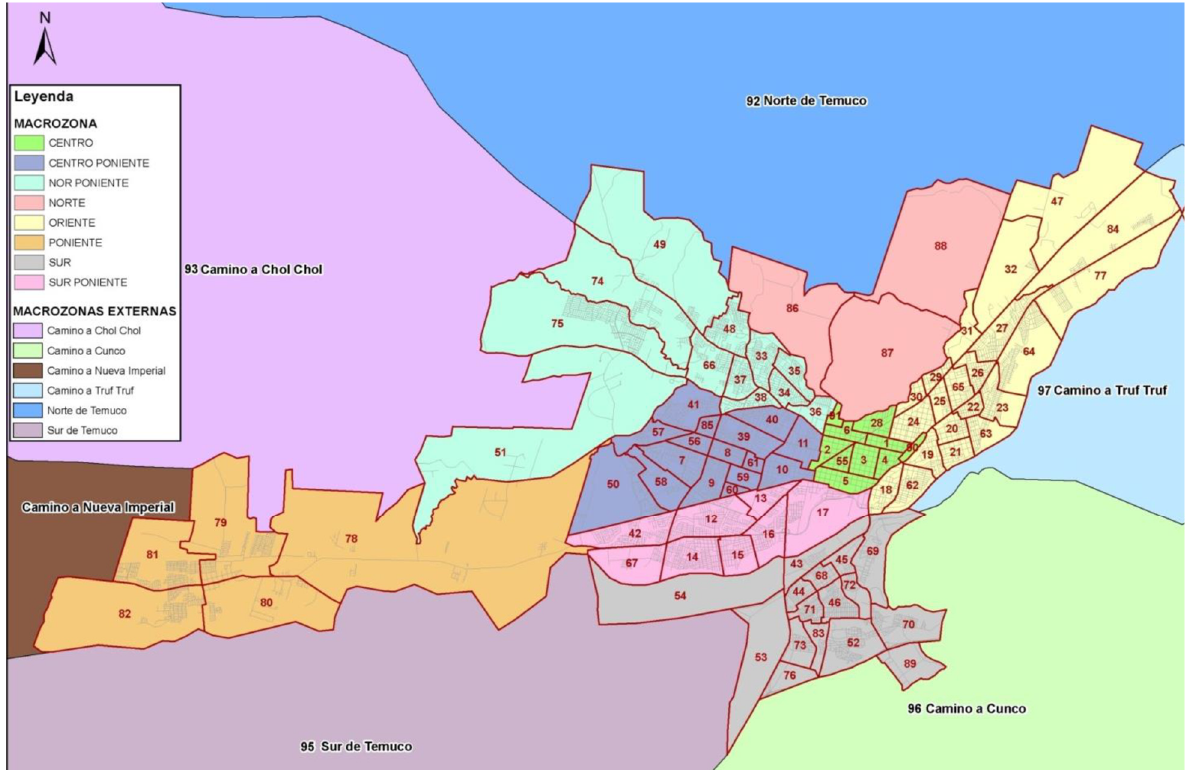
Figure 1. Zoning defined in Stage I of the travel diary study in Temuco (Taken from Actualización Plan De Transporte Temuco, Etapa II [12].